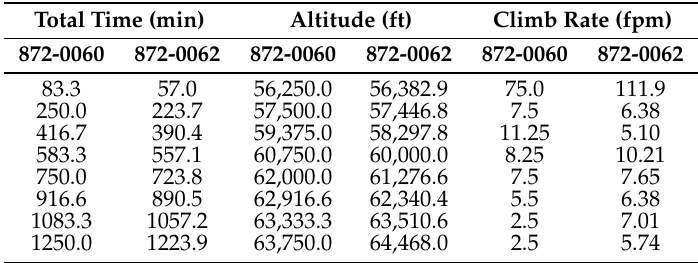
Table 4. Global Hawk cruise climb rates for Missions 872-0060 and